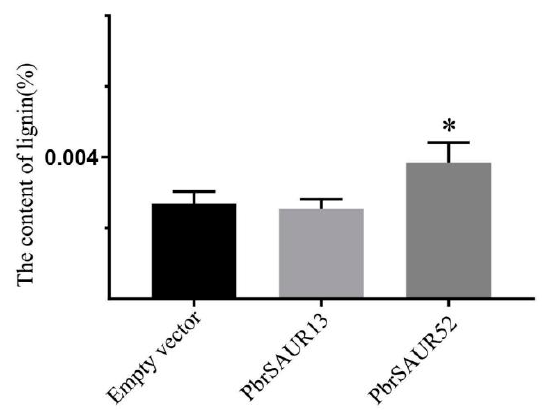
Figure 12. The contents of lignin of PbrSAUR13,52 overexpressed strawberry. * Significant difference at p < 0.05.